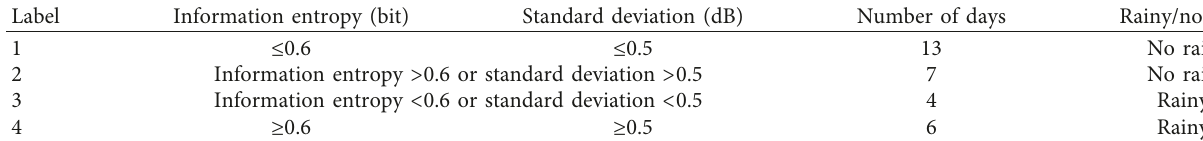
Table 1: Classification labels for 30-day test data.